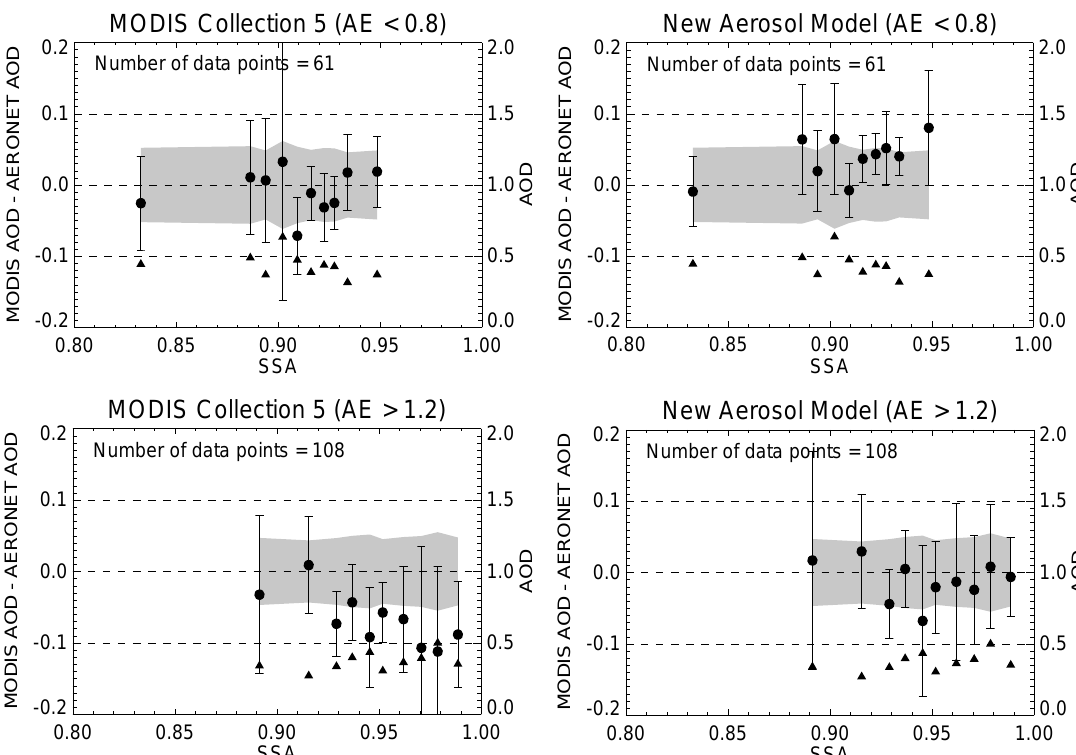
Fig. 10. SSA dependence of retrieval errors for the C005 algorithm (left) and the test algorithm (right). AERONET Level 2 SSA values are retrieved for AOD (440nm) >